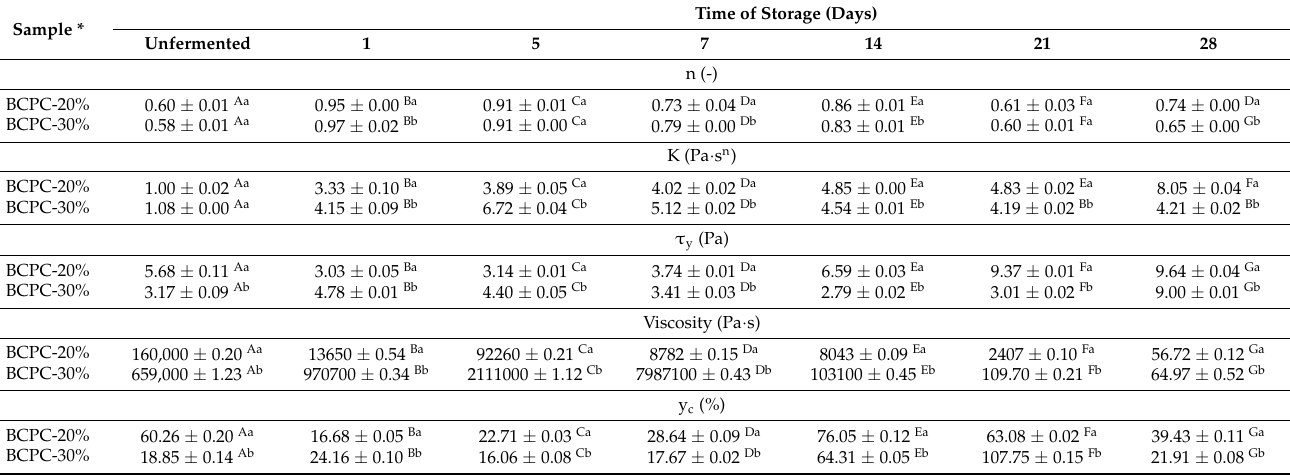
Table 4. Changes of Hershel–Bulkley parameters, viscosity, and critical point during the storage